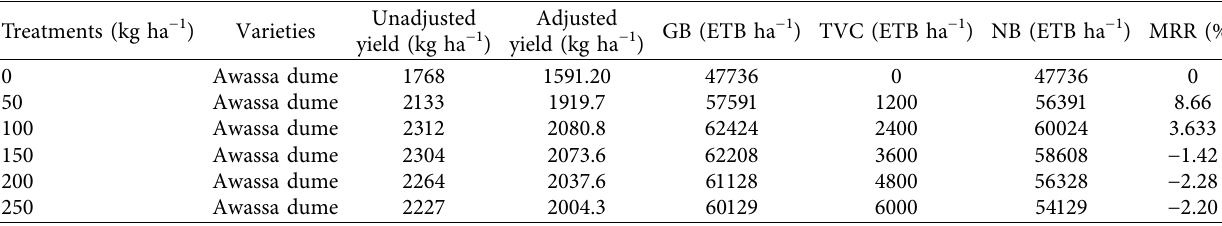
Table 7: Marginal analysis of common bean variety as infuenced by blended fertilizer